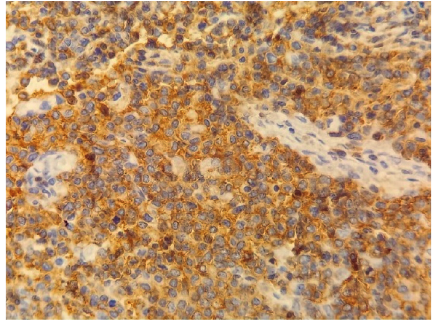
Figure 4: CD45 staining of the tumor cells